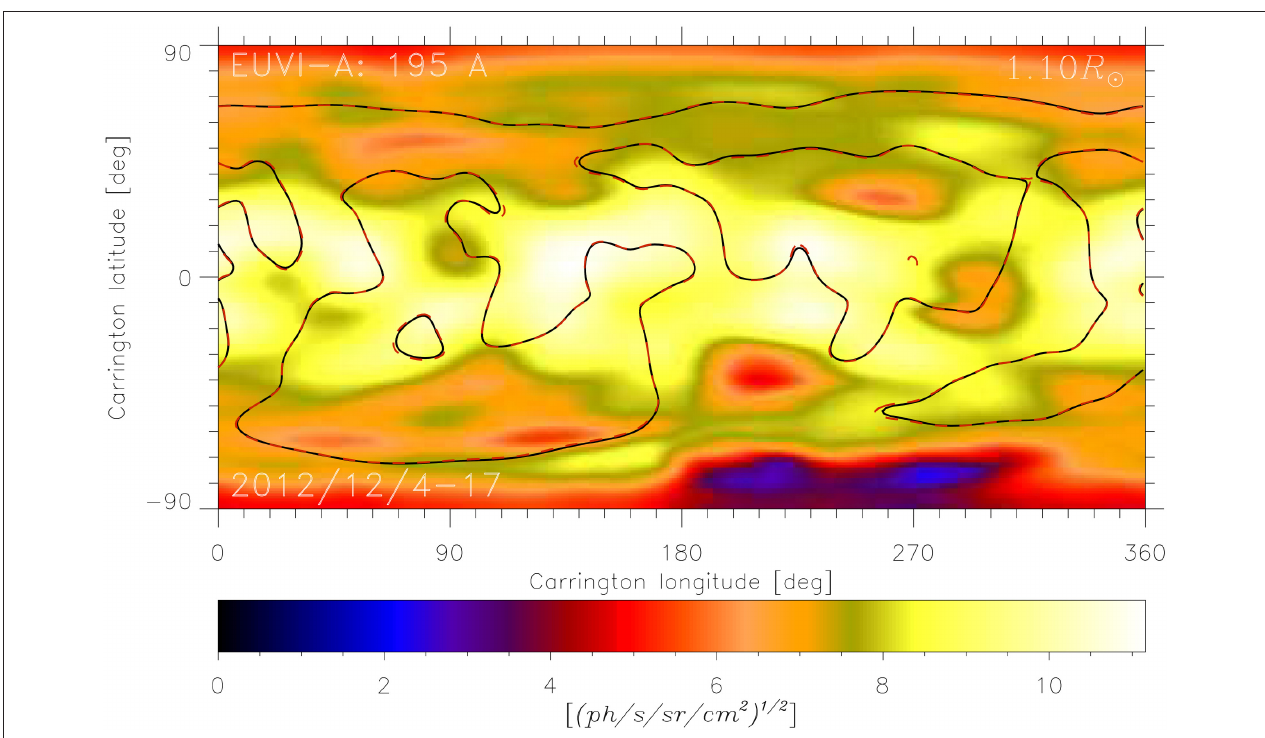
FIGURE 2 | Spherical cross-section of the reconstructed 3D EUVI 195 Å emissivity in square root scale at heliocentric distances of 1.1 R ⊙ . The reconstruction is obtained by tomography based on COR-1 data obtained during December 4–17, 2012 (CR 2131). Solid black and dashed red lines indicate the magnetic neutral line in PFSS model with source surface located at 1.5 and 2 R ⊙ ,